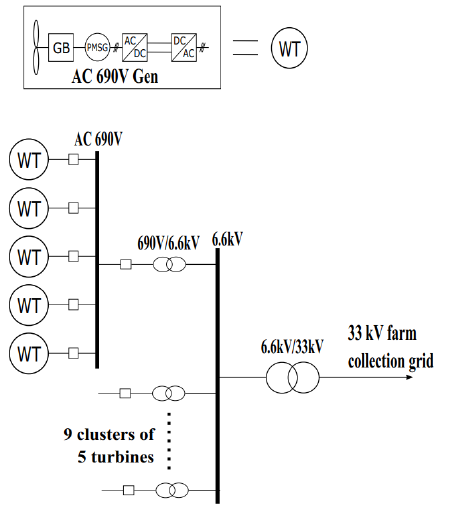
Figure 2. AC star topology.